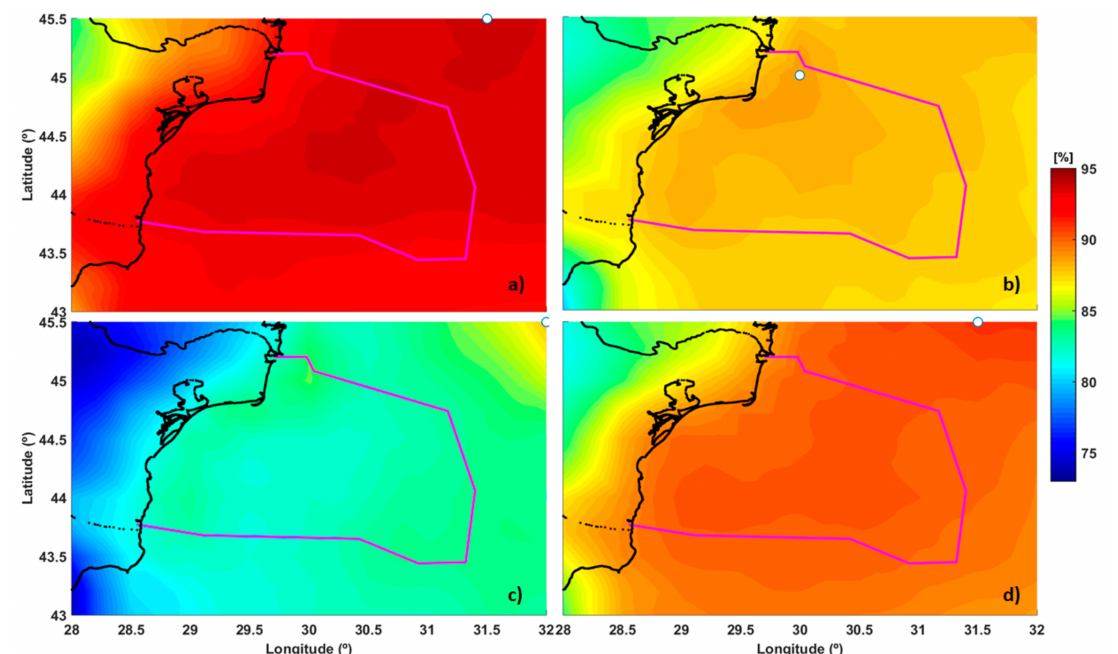
Figure 7. Seasonal percentages of the wind speed ( U 100 ) in the range between the cut-in and cut-off values (standard functional range 3–25 m/s): ( a ) winter—December–January–February; ( b ) spring—March–April–May; ( c ) summer—June– July–August; and ( d ) autumn—September–October–November. The locations of the maximum values are marked by white circles, while the Romanian EEZ is indicated by the magenta line.